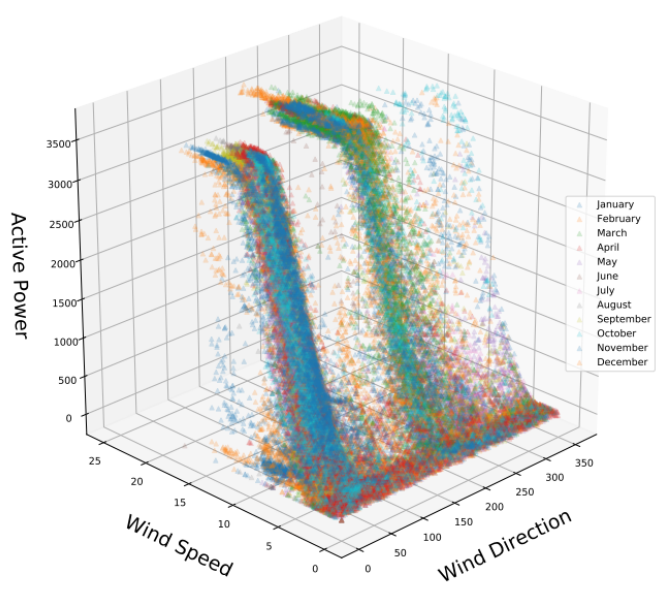
Figure 4. Scatter plot for the whole year with wind direction, wind speed, and active